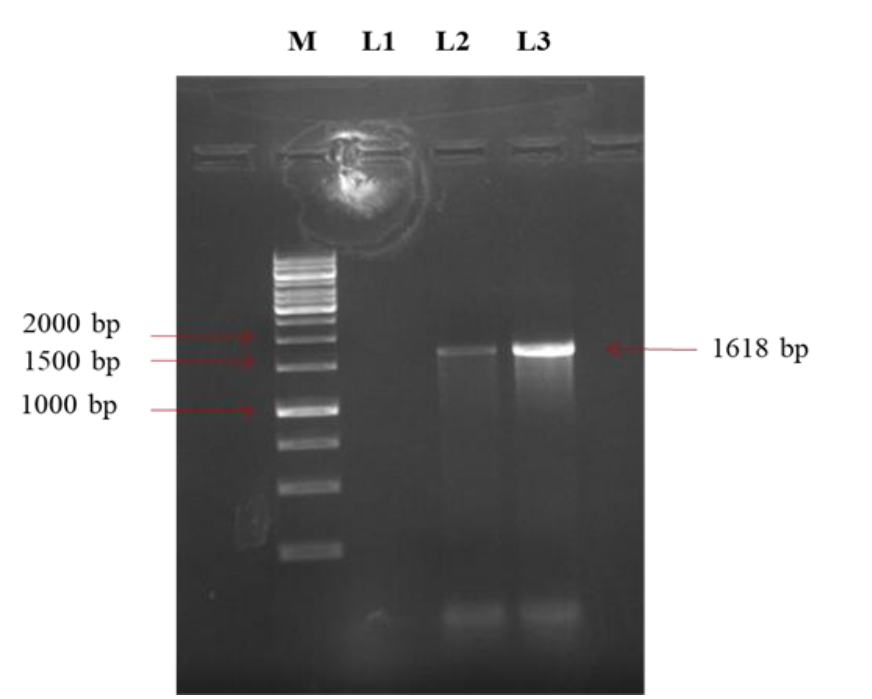
Figure 2. PCR analysis of the NDV isolates. PCR carried out with full-length F gene-specific primers. Lane 2 and Lane 3 show 1618 bp F gene amplification product of duck NDV isolate (As/Km/19/44) and parrot NDV isolate (As/WB/19/91), respectively; Lane 1, negative control and Marker (M), a 1 kb DNA ladder (Thermo Scientific, Waltham, MA, USA).